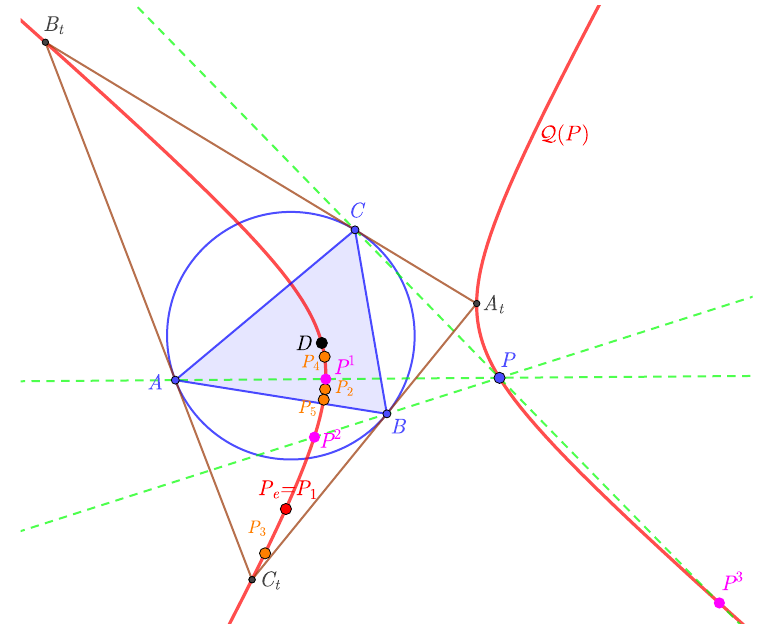
Figure 5. Points on conic Q ( P )